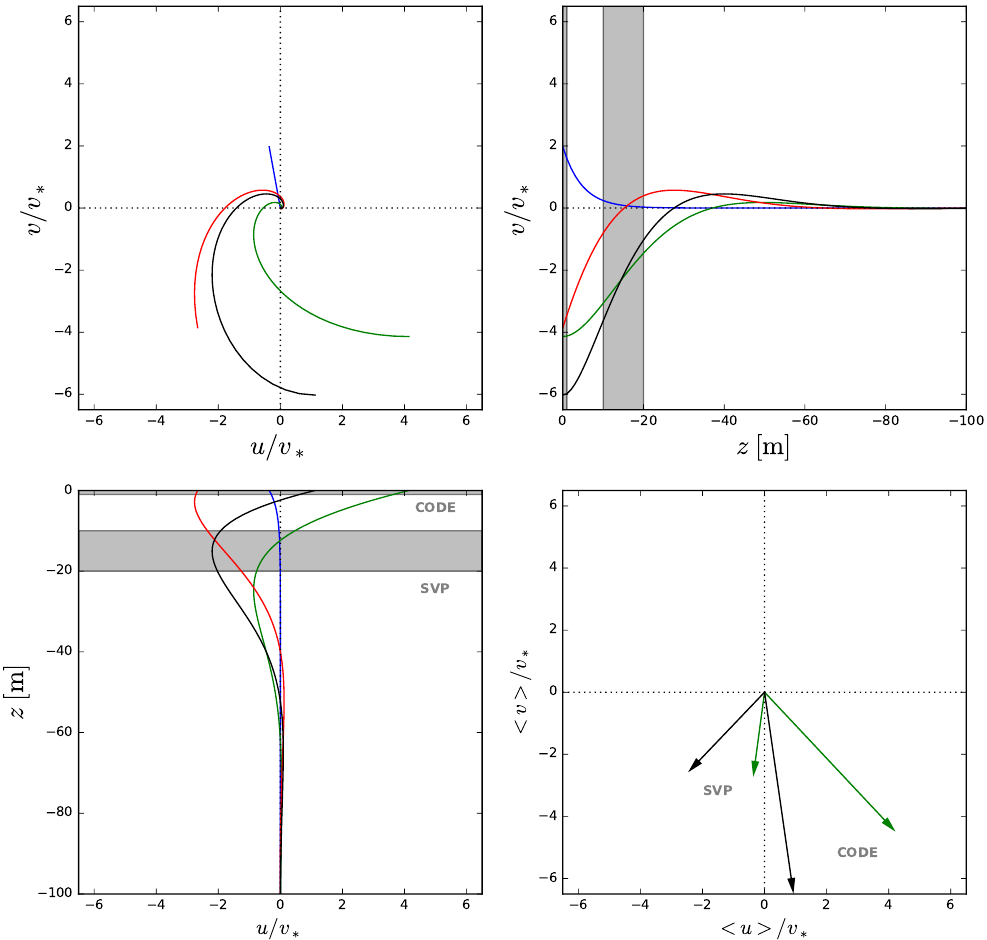
Figure 5. Ageostrophic velocity field for the Ekman component (green), the “Eulerian” Stokes component (blue), the Ekman–Stokes com- ponent (red) and the resulting velocity (black). The parameters used are the same as in Polton et al. (2005). Wind and wave propagation is in the x direction. All velocities are normalized by the friction velocity v ∗ . The paremeters used are the same as in Polton et al. (2005). Arrows in the lower-right plot correspond to the total (black) and Ekman (Green) transport a SVP and a CODE drifter would see, obtained by integrating velocities for the layers marked with gray